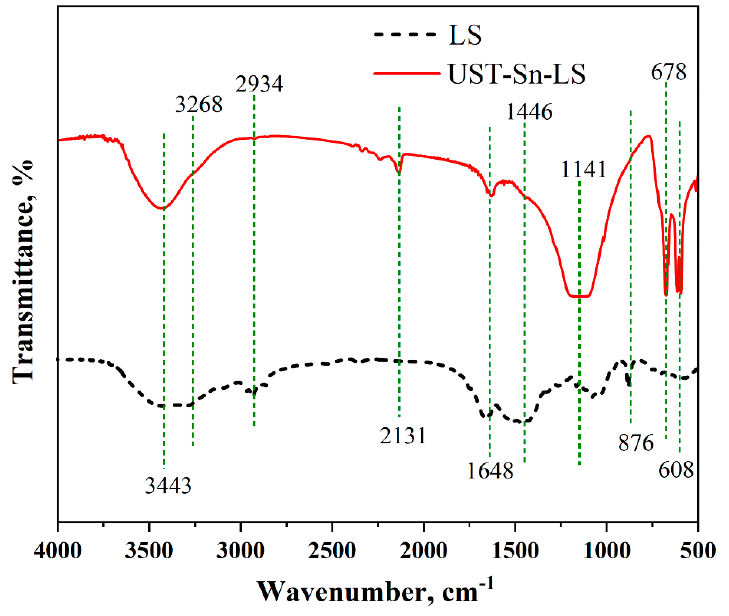
Figure 2. FTIR characterization of raw LS and UST-Sn-LS in the range of 4000–500 cm − 1 .